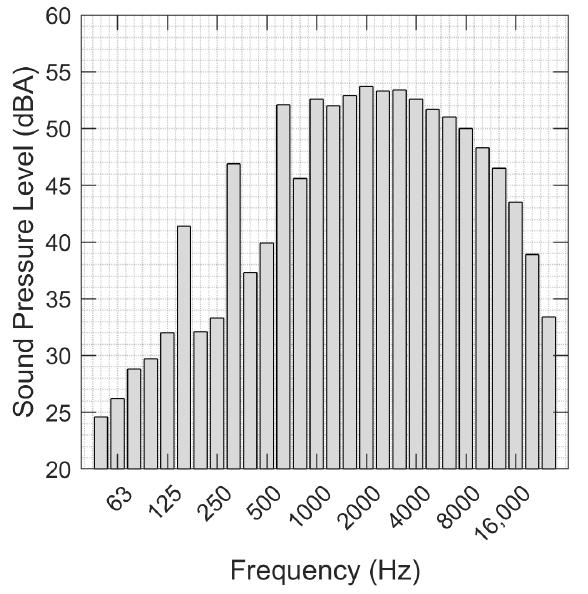
Figure 5. Hover tests—third octave band results 5 m 90 ◦